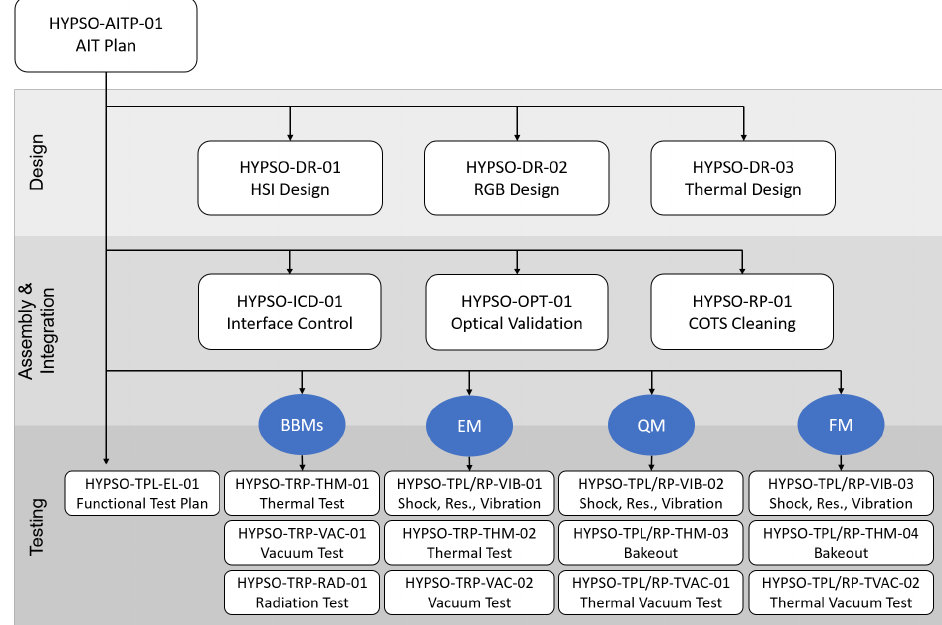
Figure 4. A summary of AIT reports written over the course of the HYPSO-1 AIT campaign.